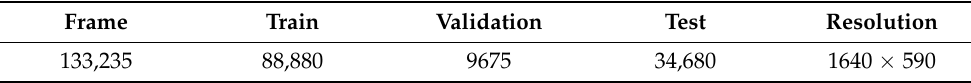
Table 2. Dataset detail.